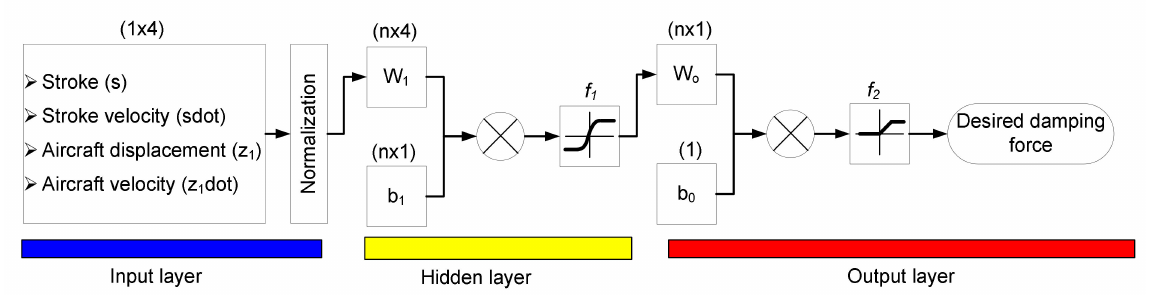
Figure 10. The structure of the neural network.